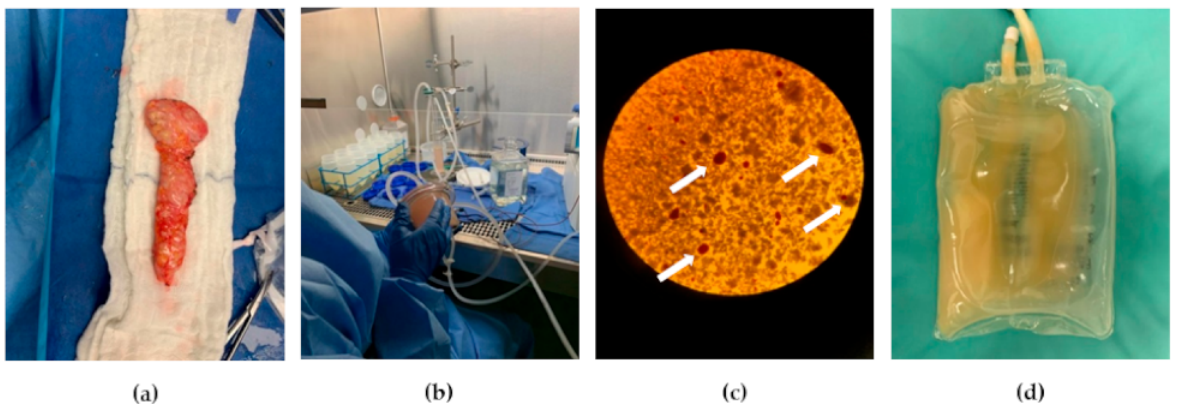
Figure 2. Total pancreatectomy with islet auto-transplantation (TPIAT): ( a ) Resected pancreas after removal of duodenum and vessels; ( b ) Enzymatic and mechanical digestion of the resected pancreas; ( c ) After collection of digested pancreatic tissue, samples are taken for microscopic inspection to assess islet size, number, and morphology with dithizone staining. White arrows indicate stained islet cells; ( d ) Digested pancreatic tissue with islets were transferred to an infusion bag for